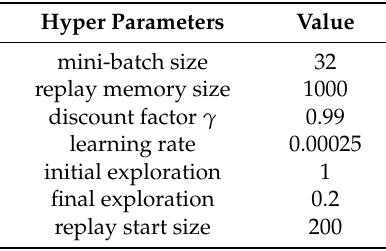
Table 2. Summary of the DRL-based algorithm hyper parameters.